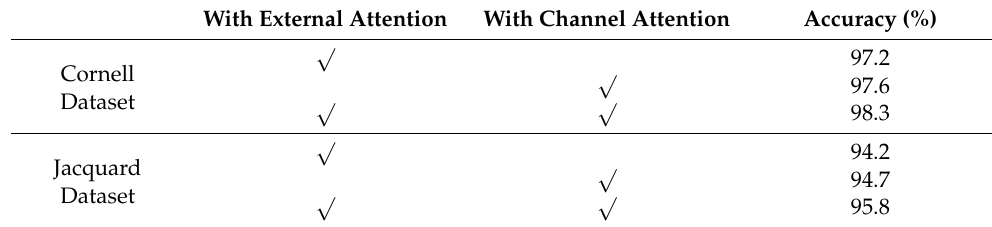
Table 3. The comparison results on Jacquard Dataset.